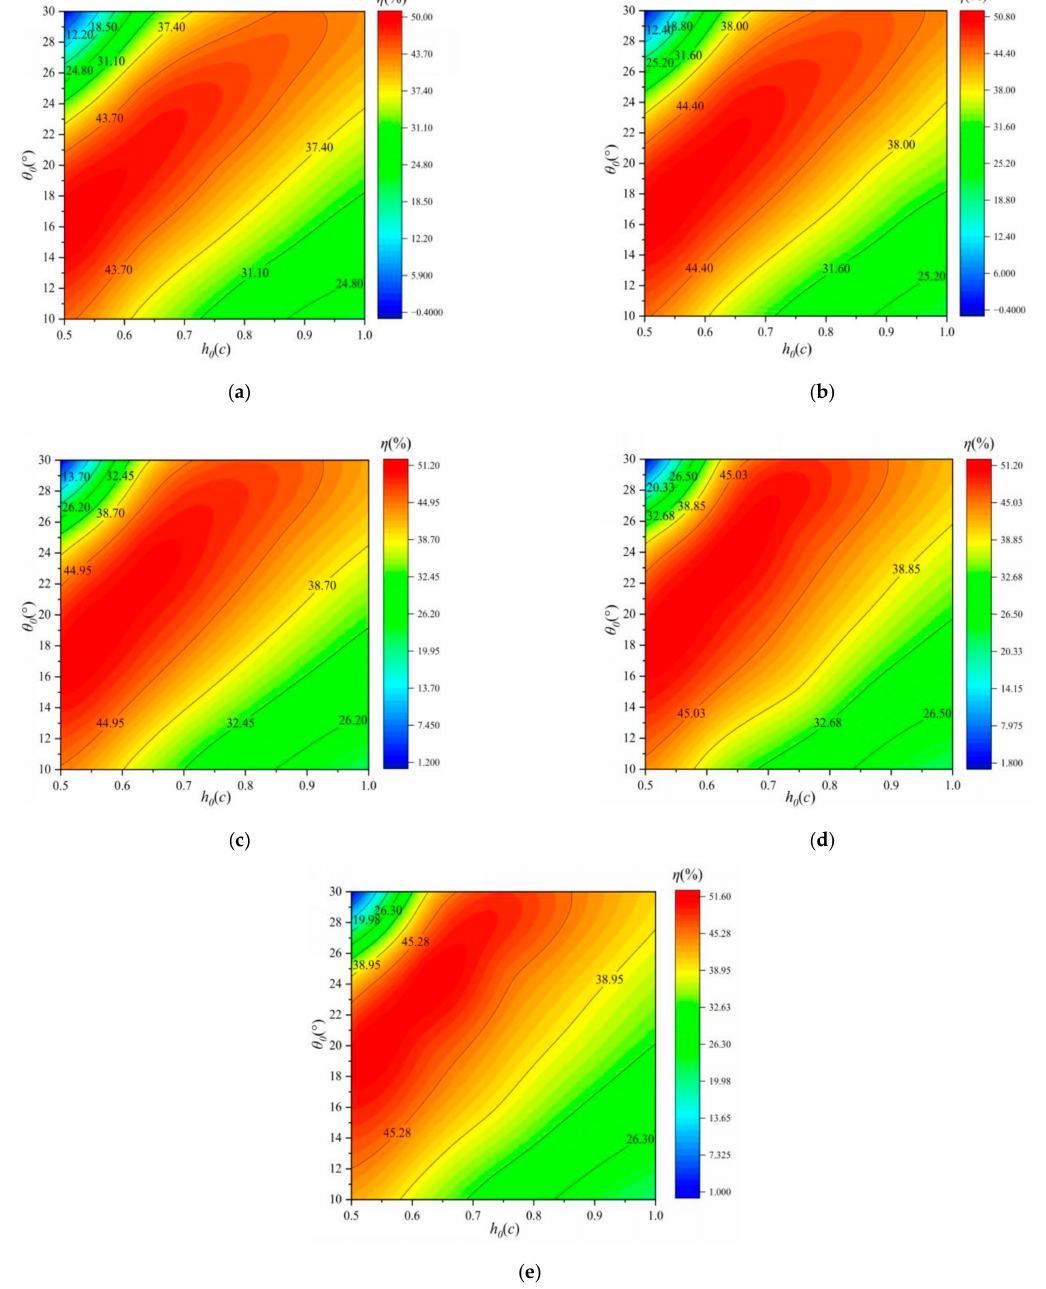
Figure 9. Variation of average propulsion efficiency with heave motion amplitude under different phase differences and pitch amplitudes ( a ) ϕ = 60 ◦ ( b ) ϕ = 75 ◦ ( c ) ϕ = 90 ◦ ( d ) ϕ = 105 ◦ ( e ) ϕ = 120 ◦